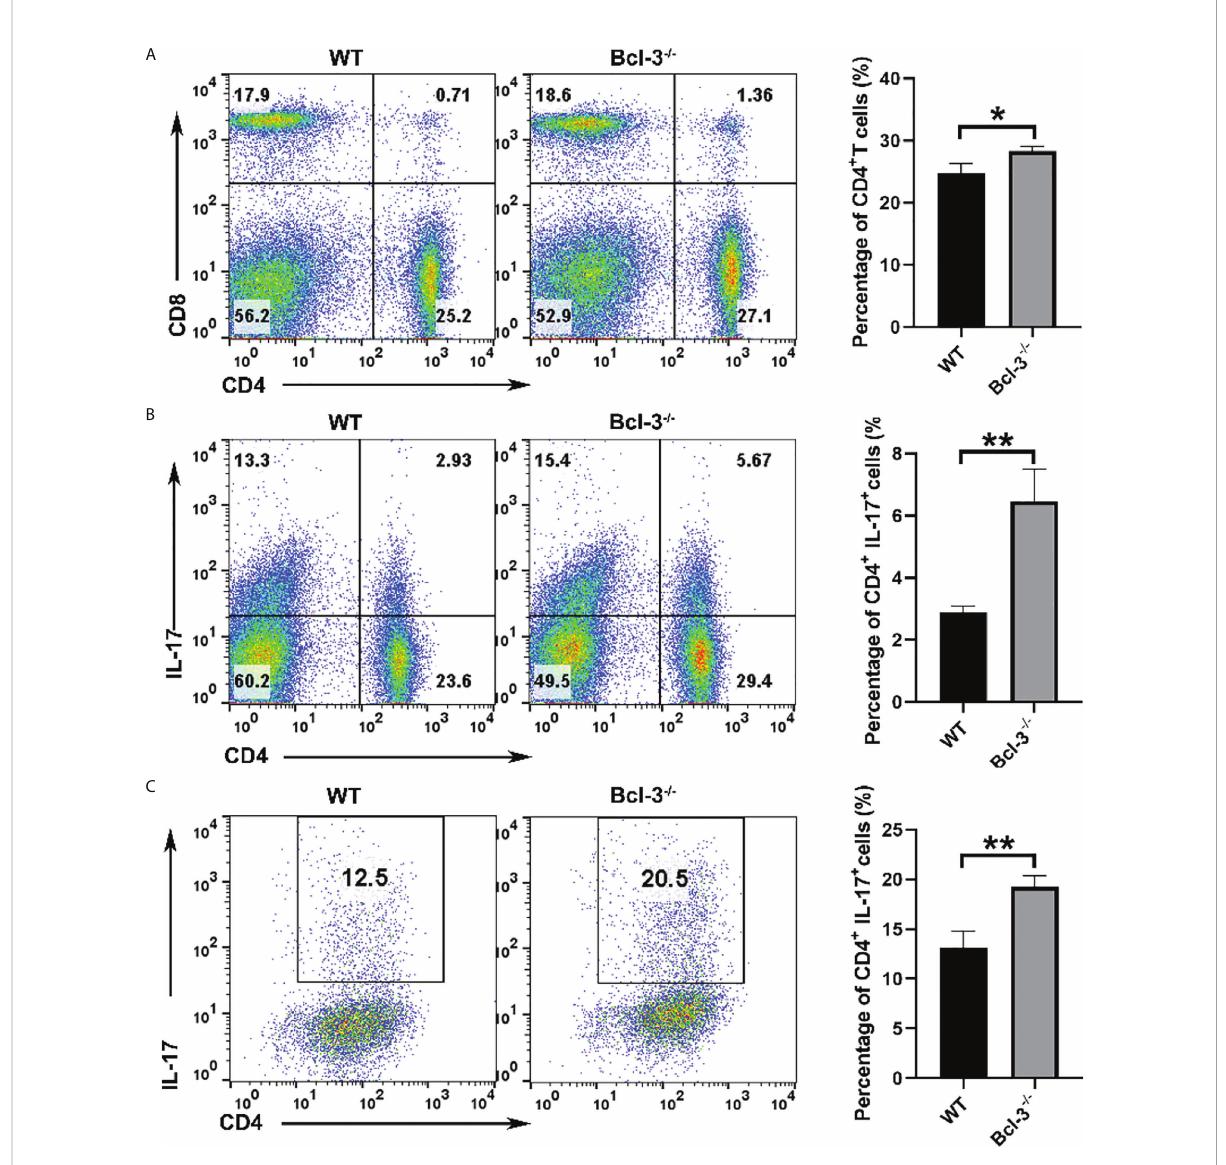
FIGURE 1 Loss of Bcl-3 diminished numbers of CD4+ T cells and increased numbers of Th17 cells. Lymphocytes were isolated from spleen of Bcl-3 -/- and WT mice and analyzed by FACS. (A) Flow cytometry plots gated on CD4 + T cells and statistical analysis. (B) Percentage and statistical analysis of IL-17 + CD4 + T cells. (C) Differentiation Th17 cells were induced using in vitro polarization assay, and the percentage of Th17 cells were detected by FACS. n = 3 for each group. Data above are representative of 3 independent experiments. *P <0.05, **P